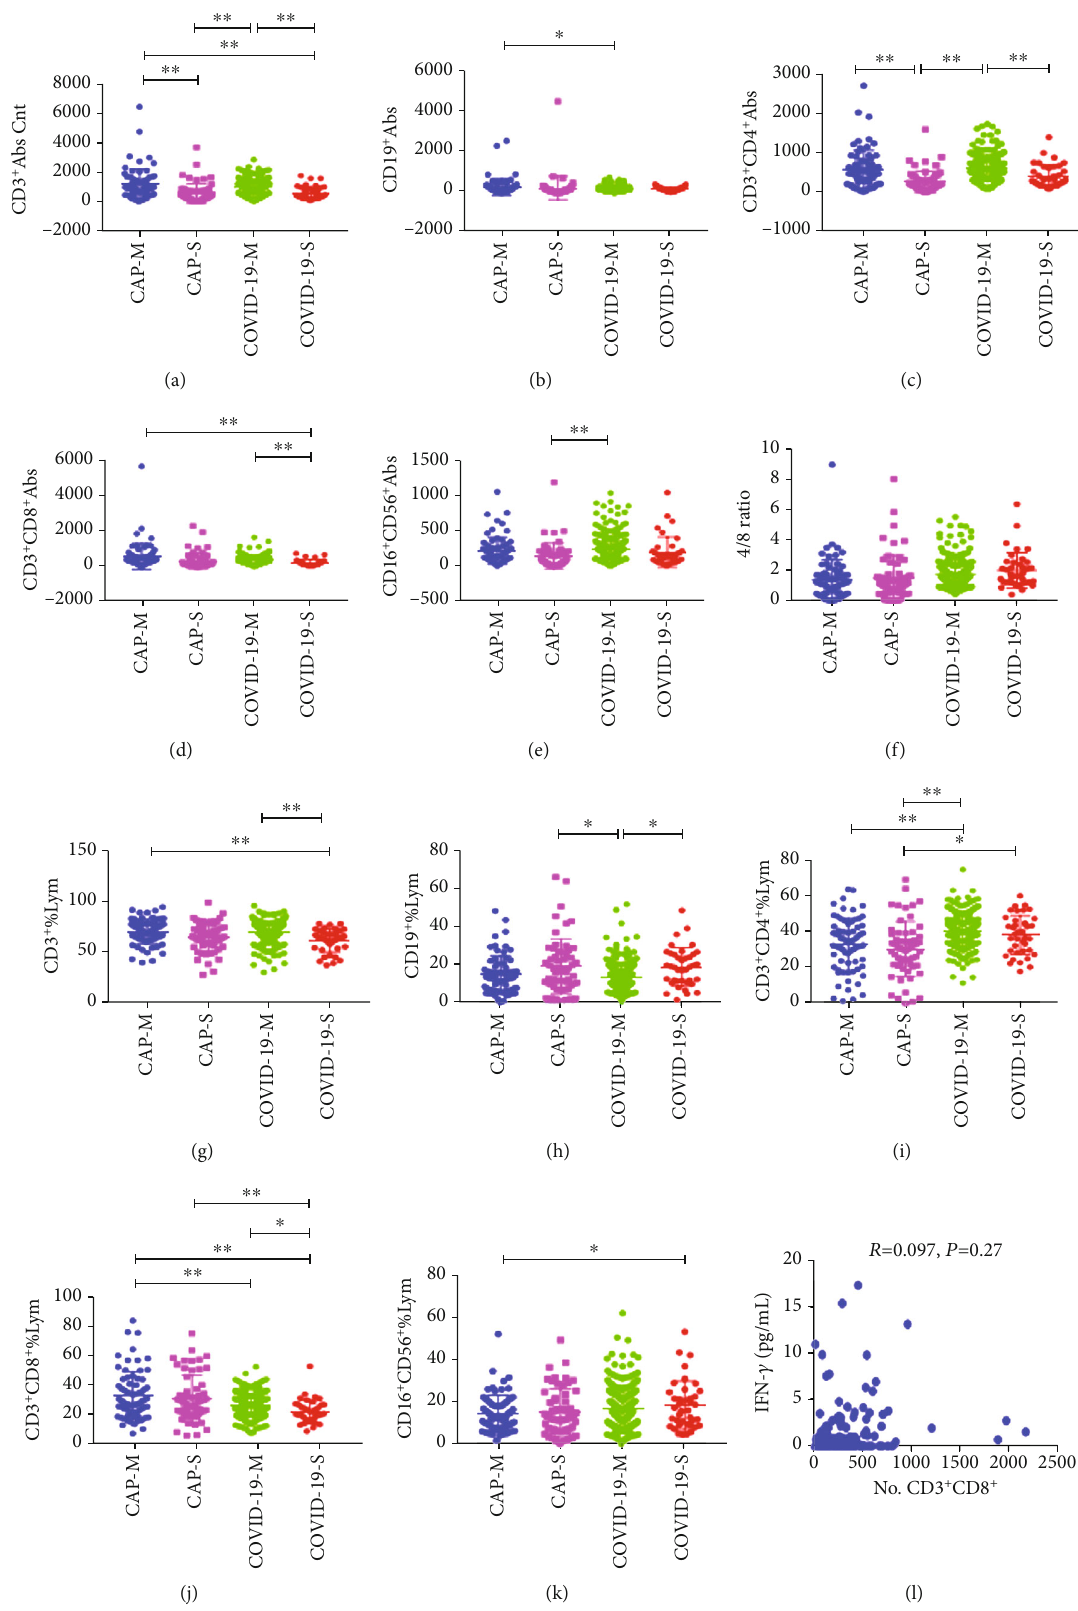
Figure 3: General characteristics of lymphocyte subpopulations in mild CAP patients (CAP-M), severe CAP patients (CAP-S), mild COVID- 19 patients (COVID-19-M), and severe COVID-19 patients (COVID-19-S). ∗ p < 0 : 05 , ∗∗ p < 0 : 01